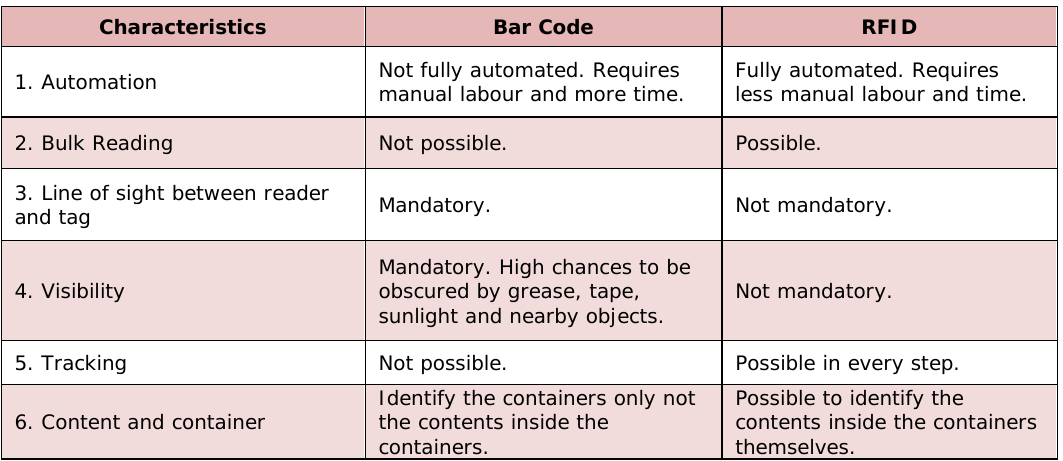
Table 1. “Advantage of RFID over bar code”. Source: Thoroe, Melski and Schumann (2009) and Want